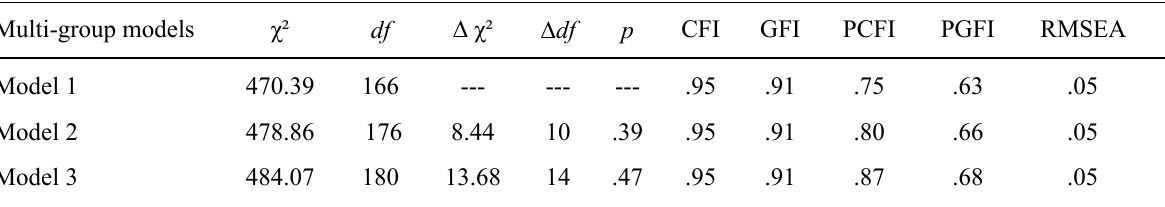
Results of the Multi-Group Analysis across the Unconstrained Model and the Constrained Models of the AIMS-plus (Testing sample: n=328; Validation sample: n=322) Multi-group